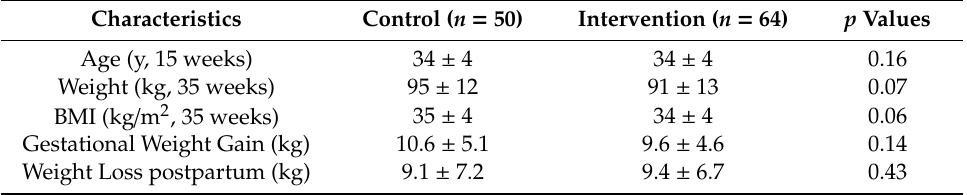
Table 2. Characteristics of study volunteers. Summary statistics of the subsample of the MOMFIT trial (114 individuals: 50 control and 64 intervention) included in the metabolic profiling study. Values represent means and standard errors, and p -values (calculated through 2-tailed Student’s t